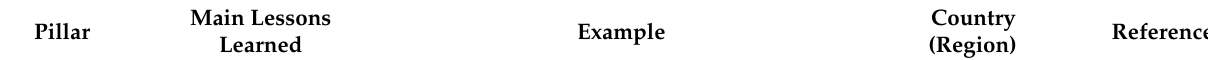
Table 1. Practical examples from most reported lessons learned in the 10 pillars (from WHO COVID-19 Operational Planning